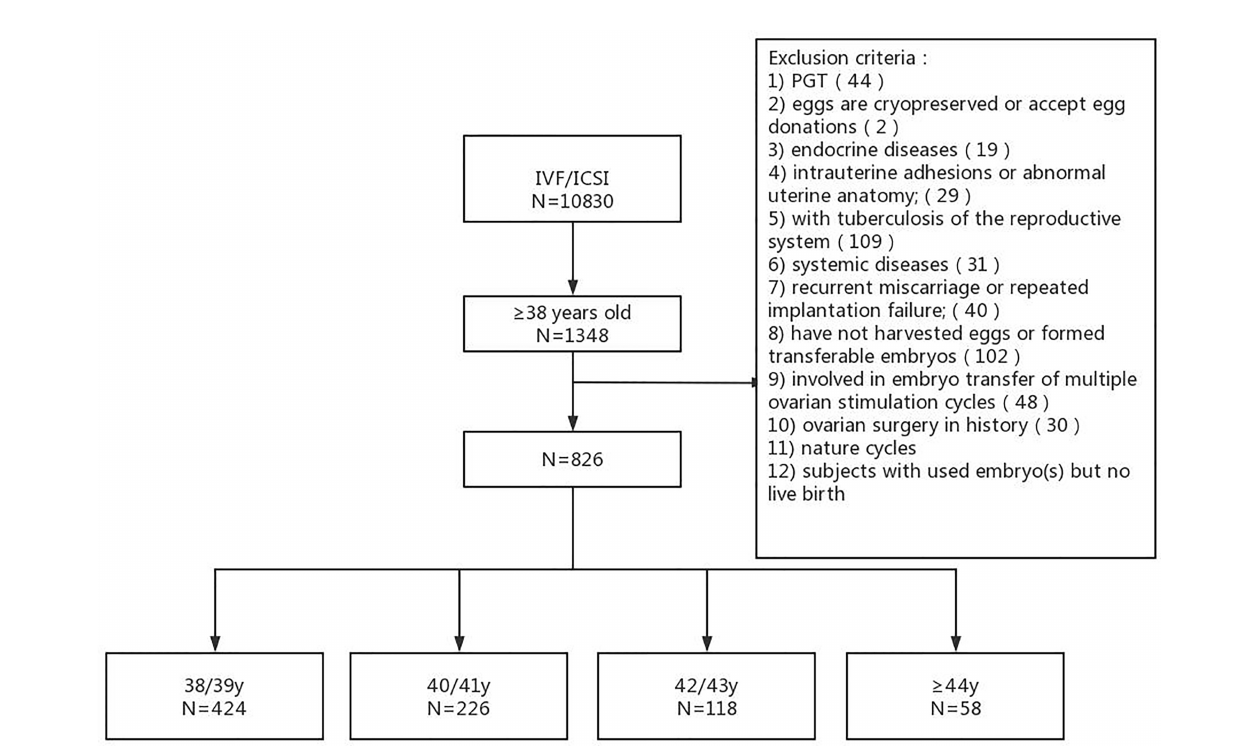
FIGURE 1 | Study fl ow